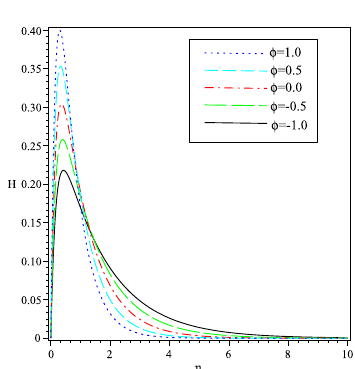
Fig. 14: Graph of (cid:107) Res (cid:107) 2 by direct RBFs solution for ϕ = 0 , β = 0.4 and ε = 0.1 .